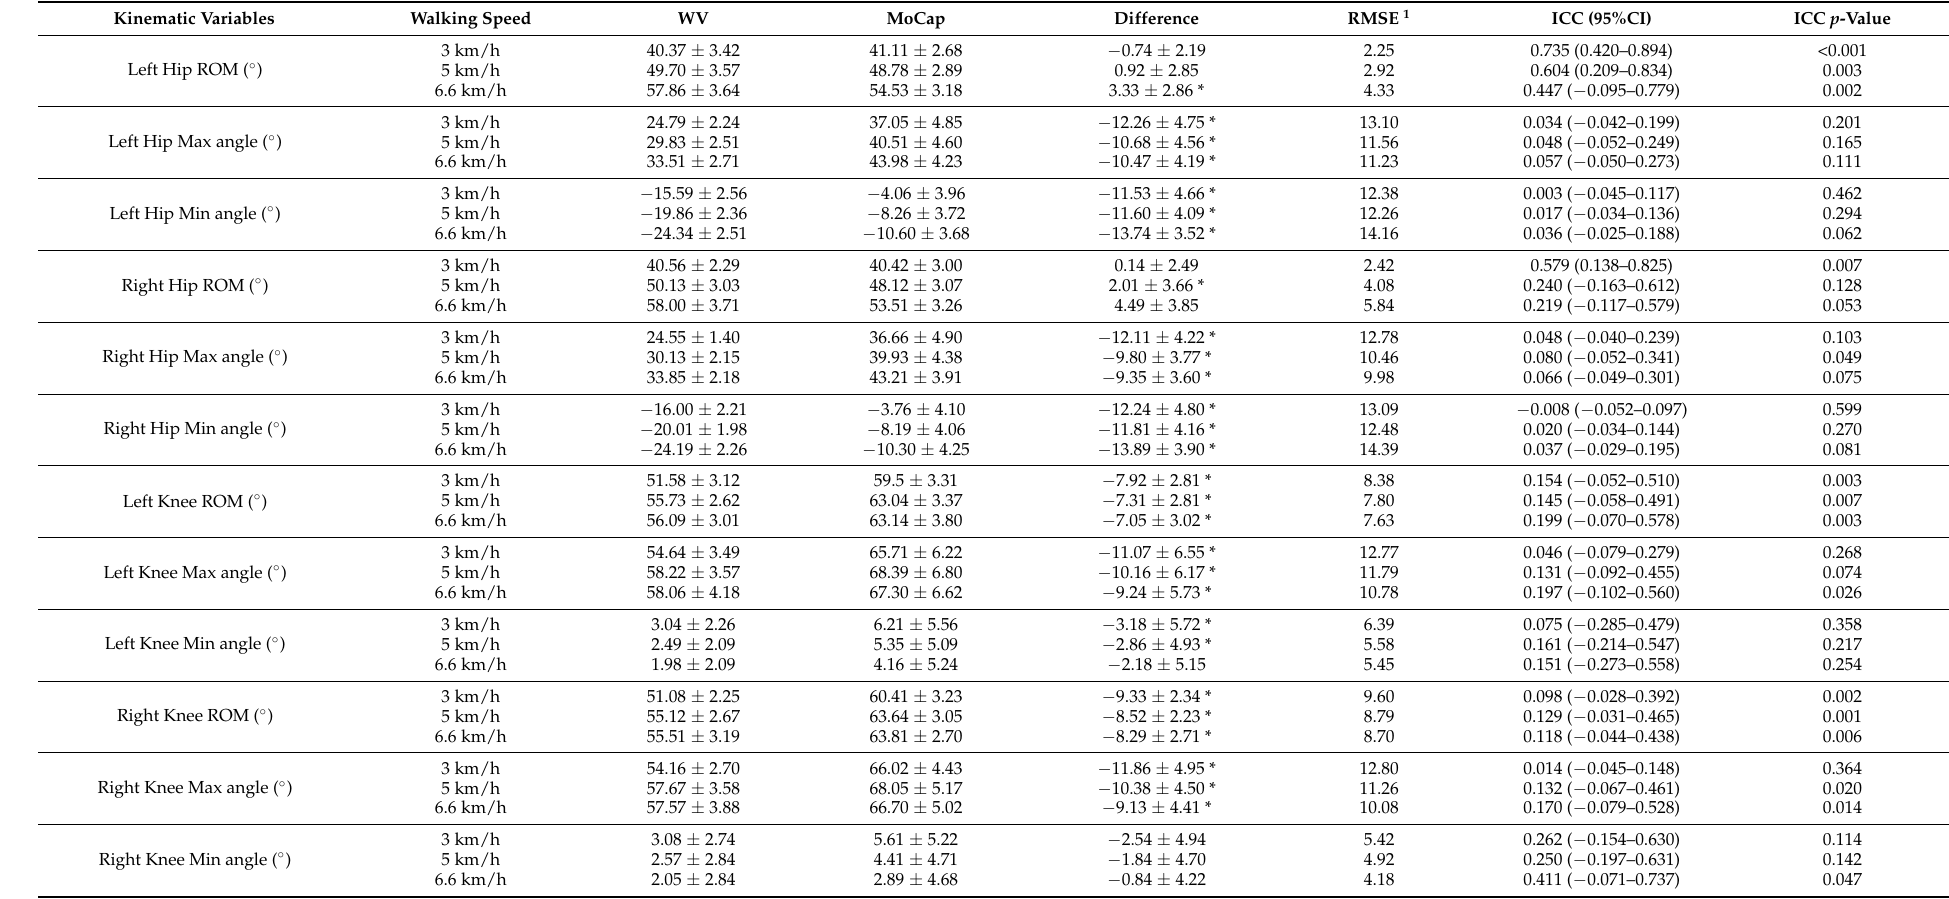
Table 3. Kinematic variables. Kinematic variables obtained from the WV and MoCap systems, at all the tested walking speeds. All the values are reported as mean ± standard deviation, considering the values from all the volunteers. Per each walking speed, the difference between the WV and MoCap (Difference), the Root Mean Square Error (RMSE), the ICC, with 95% CI and relative p value, are also